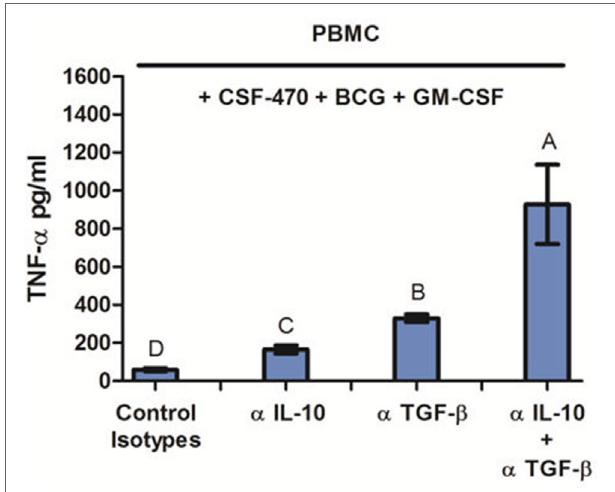
FigUre 6 | TNF- α release by peripheral blood mononuclear cell coculture with CSF-470 plus adjuvants at 24 h in the presence of blocking antibodies against IL-10 and/or TGF- β . Bars with different letters are statistically different ( p < 0.05), n =